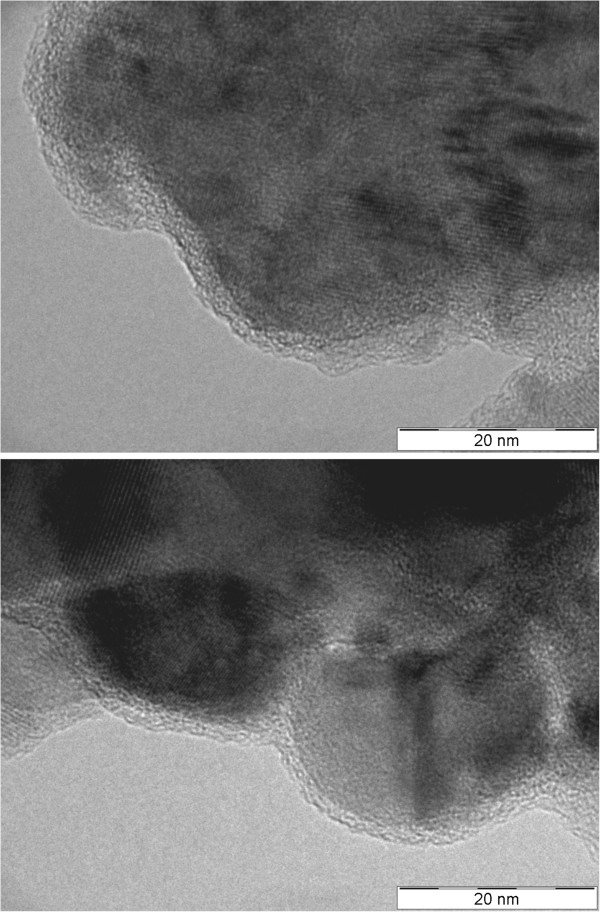
TEM micrograph of the sample prepared by heating of 1a up to 600°C demonstrating the presence of CoFe2O4-Co3O4 in the form of nanocomposite particles.